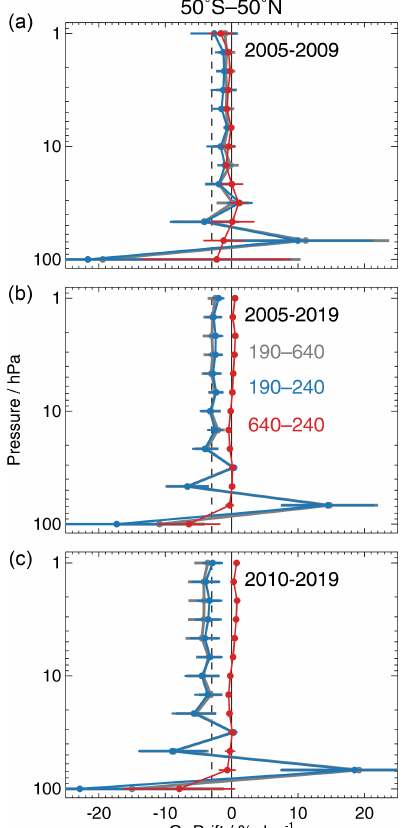
Figure 7. Profiles of linear fits obtained from differences between the MLS v4 ozone products based on the 190, 240, and 640GHz receivers over 50 ◦ S–50 ◦ N for different time periods (see legend). Error bars are 2 σ intervals estimated from block bootstrapping. The solid vertical line marks zero drift, and the dashed vertical line in- dicates a − 3% per decade